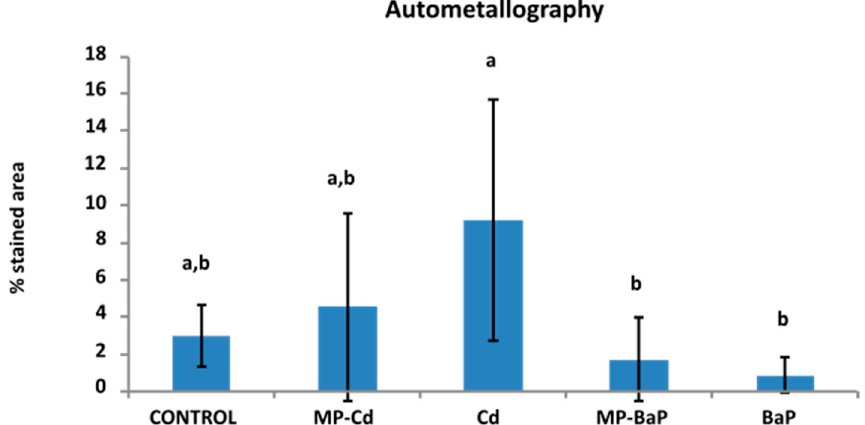
Figure 6. Results of the quantitative analysis of the autometallographical staining of the digestive gland. Mean ± standard deviation ( n = 7–10). Different letters indicate statistically significant differences ( p < 0.05), according to the Dunn’s post hoc test after performing a one-way Kruskal–Wallis test.